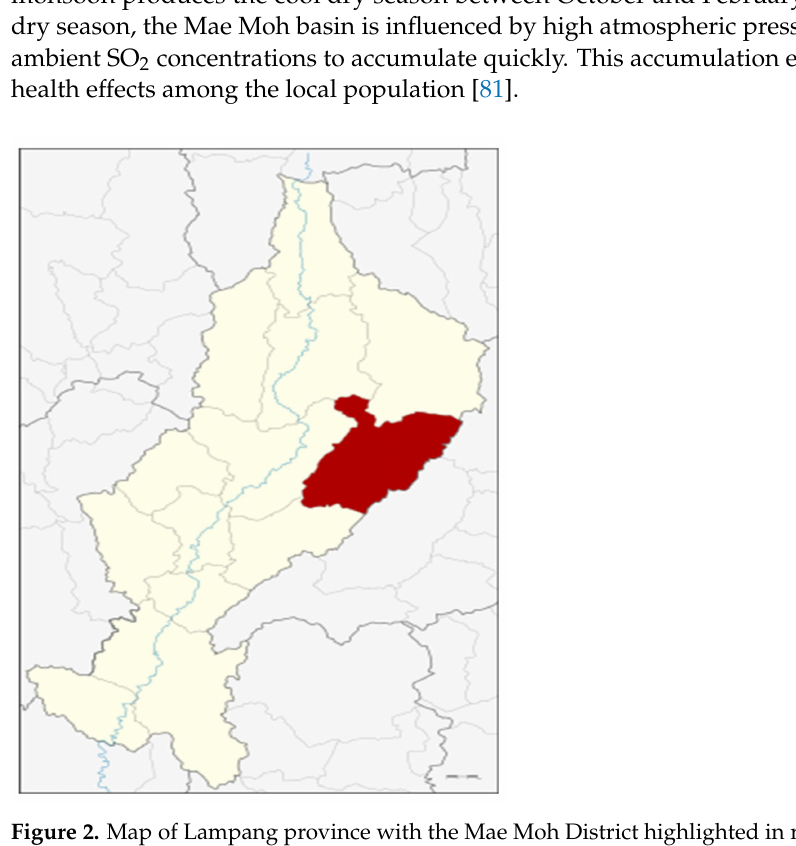
Figure 2. Map of Lampang province with the Mae Moh District highlighted in red. Source: